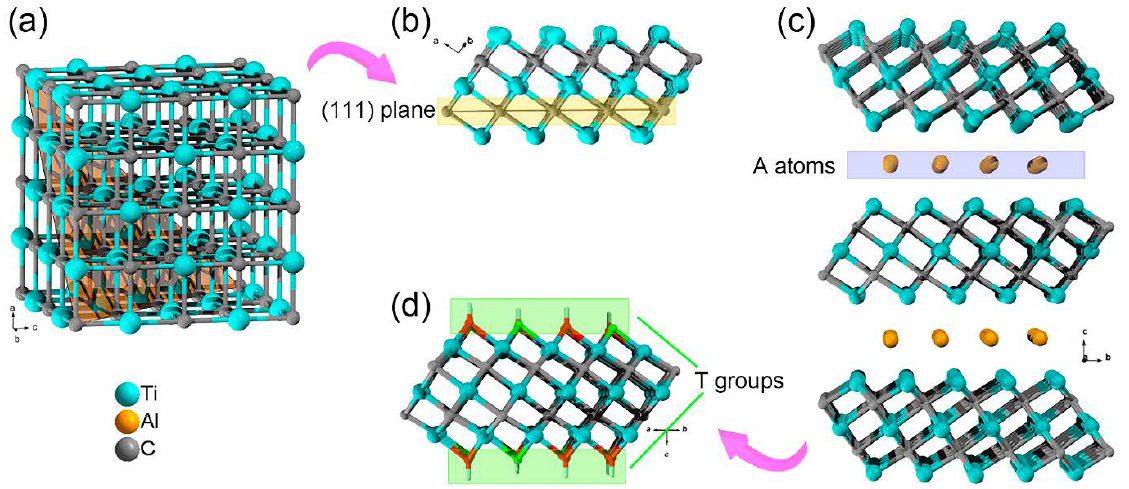
Figure 19. ( a ) Typical fcc lattice of transition metal carbide M; ( b ) a layer separated from the fcc lattice along the (111) plane; ( c ) side view of M 3 AX 2 , and ( d ) MXene monolayer M 3 X 2 T x with a terminated surface [100].